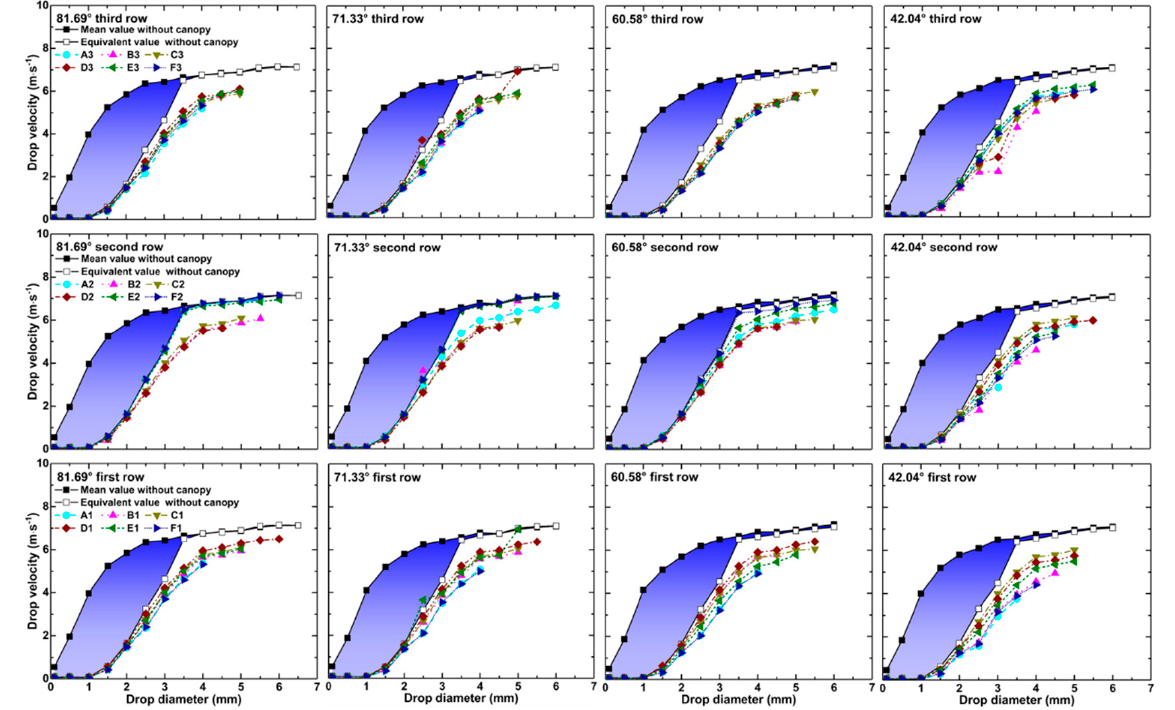
Figure 13. Spatial variation of drop velocity distribution of throughfall with different treatments. In this paper, drop equivalent velocity in each diameter interval is calculated for a graded range of 0.50 mm, separately. Taking the equivalent velocity of droplets at 3.00 mm as an example, the kinetic energy is calculated using the sum of kinetic energy of each droplet in the drop diameter range of 2.51–3.00 mm, and the quality is calculated in the similar method. In addition, the filled part in each subplot is the difference between the mean velocity and the equivalent value without canopy.